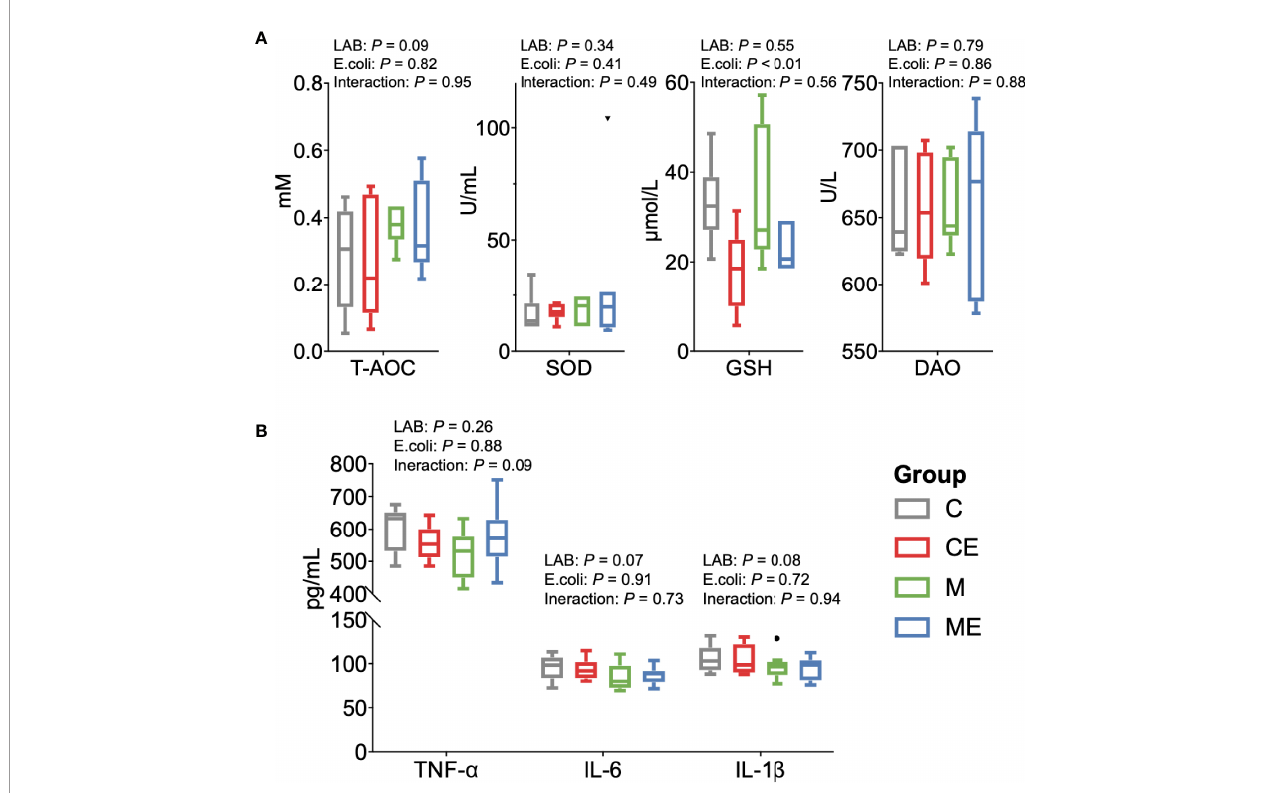
FIGURE 5 | Oxidant and in fl ammation status of the serum in control mice (C), control mice challenged with Escherichia coli (CE), mice fed mixed LAB strains (M), and mice fed mixed LAB strains and challenged with Escherichia coli (ME). (A) Oxidative stress parameters and (B) cytokines in the serum of mice between four groups. T-AOC, total antioxidant capacity colorimetric; SOD, superoxidase dismutase; GSH, glutathione; DAO, diamine oxidase; TNF- a , tumor necrosis factor alpha; IL,